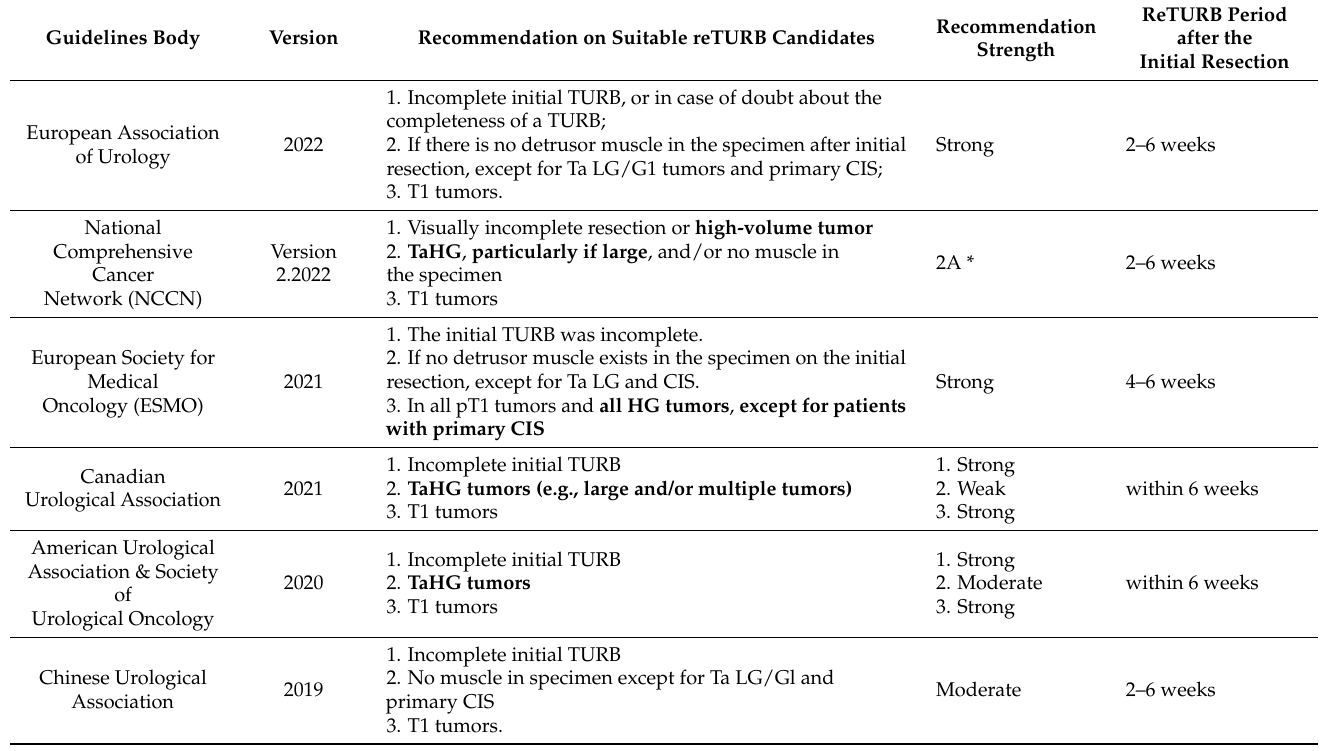
Table 1. ReTURB recommendations across international guideline